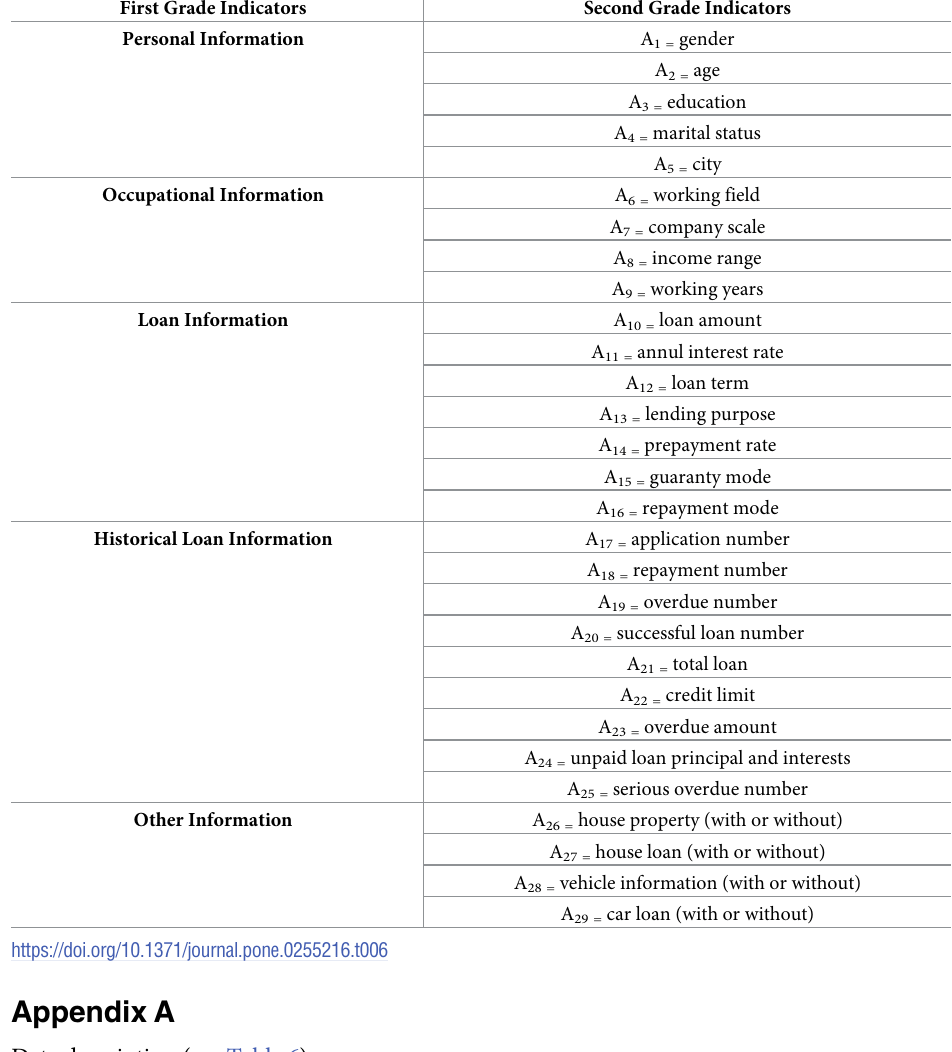
Table 6. P2P lending borrower credit risk assessment indicators.